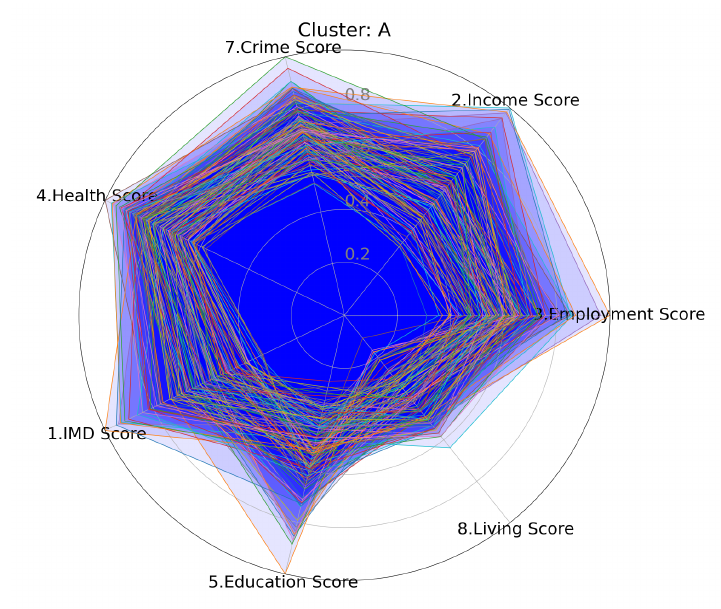
Figure 5. Stacked radar graphics showing cluster A of normalized values for case